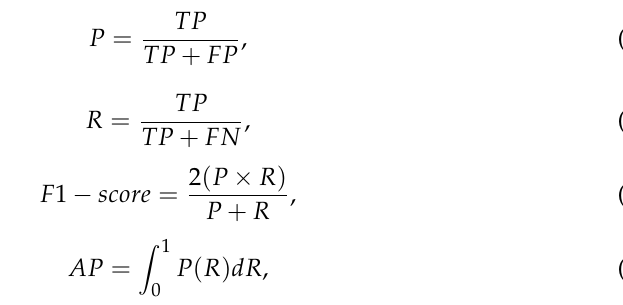
dicted is predicted crown polygons.The performance of the Mask R-CNN and ACE R-CNN was eval- evaluated using precision ( P ), recall ( R ), F1-score , and average precision ( AP ). P is the correctness of